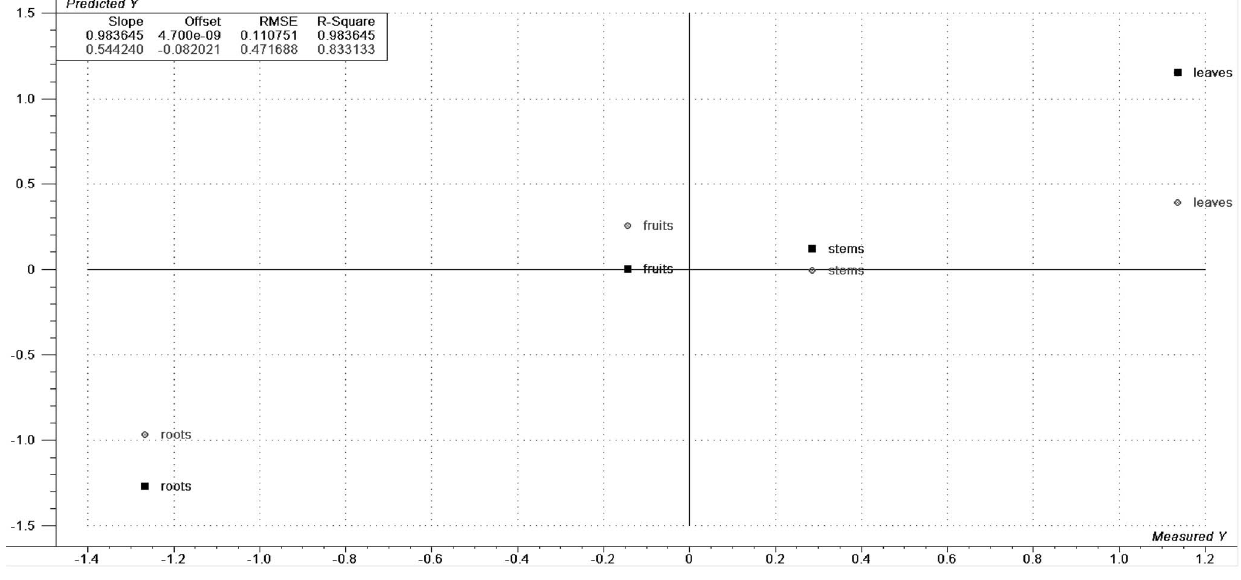
Figure 2. Calculated (squares) and predicted (circles) PLS data. These data were generated from 1 H NMR data, versus measured and autoscaled LC 50 values of P. tuberculatum extracts for B. glabrata .